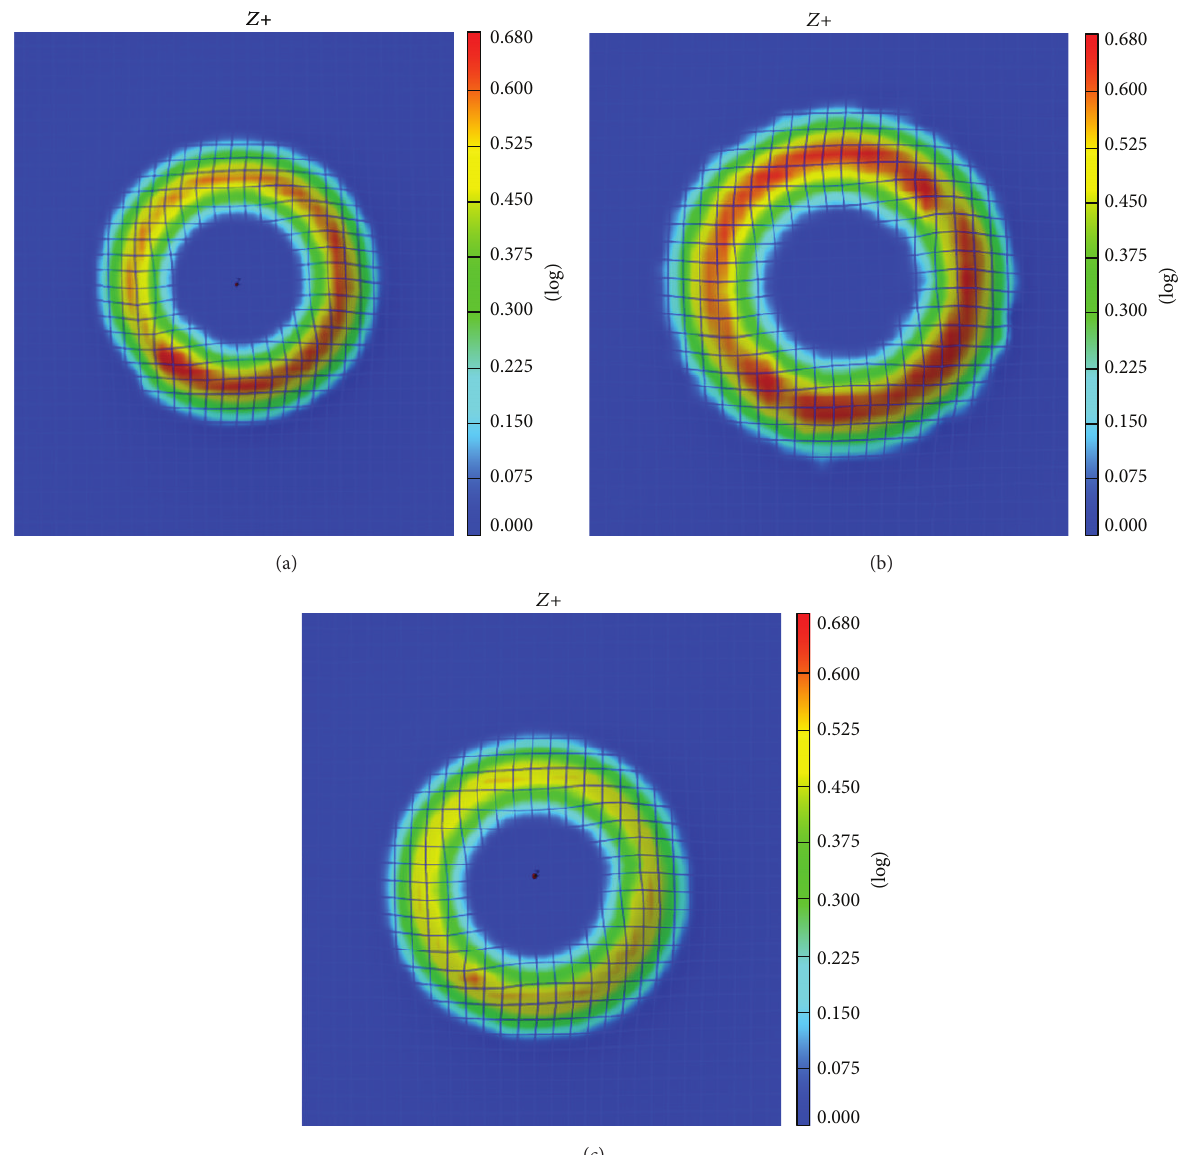
Figure 6: The thickness reduction variation for the specified three different